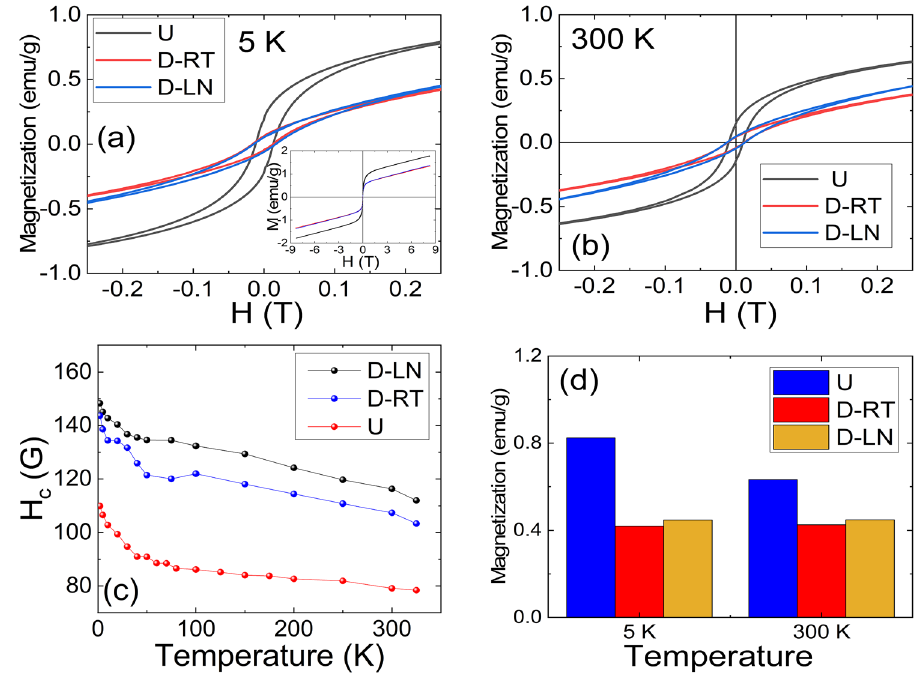
Figure 7. ( a , b ) Magnetic field dependence of the zero field cooled magnetization at indicated temperatures, Inset ( a ) high magnetic field measurements of the magnetic moments at the indicated temperature. ( c ) Temperature evolution of the coercive fields ( d ) Mass magnetization in a field of 0.25 T for undeformed and deformed